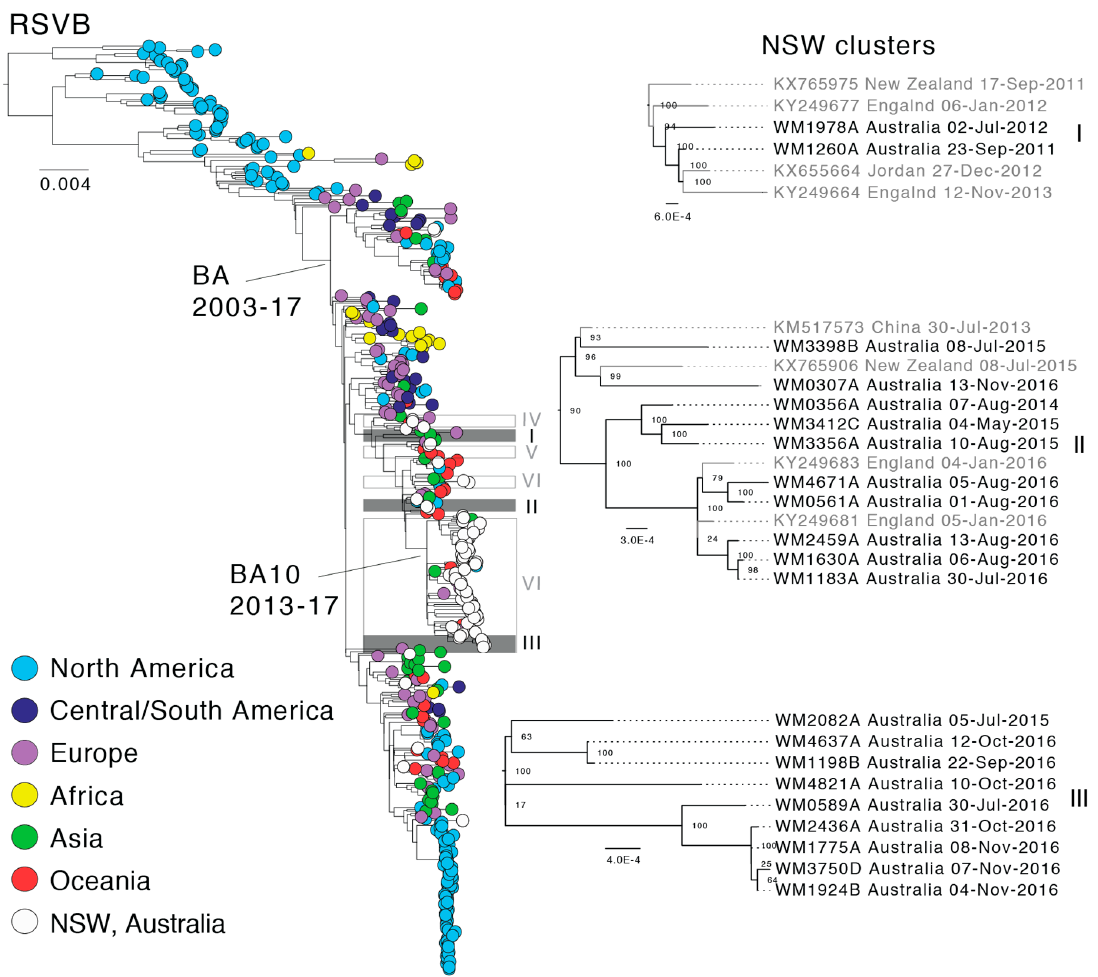
Figure 4. Global phylogeny of respiratory syncytial virus subtype B (RSVB) and local clustering within NSW. The maximum likelihood tree shown was estimated using complete RSV genome sequences. The tree was rooted using RSVA as an outgroup and the BA and BA10 genotypes are marked. Tip colors represent the sampling location and sequences from this study are shown in white. Local clusters comprising NSW sequences are marked within the global tree and the three clusters with potential multi ‐ season transmission events are colored grey and enlarged on the right side. Node supports are indicated and branch lengths are scaled according to the number of substitutions per site.